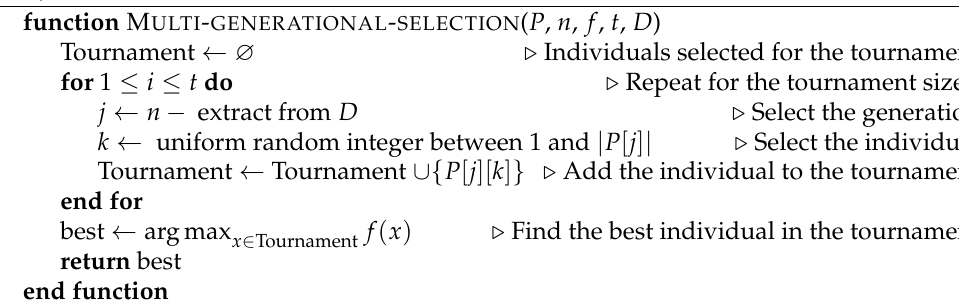
Algorithm 1 The pseudocode of the multi-generational (tournament) selection